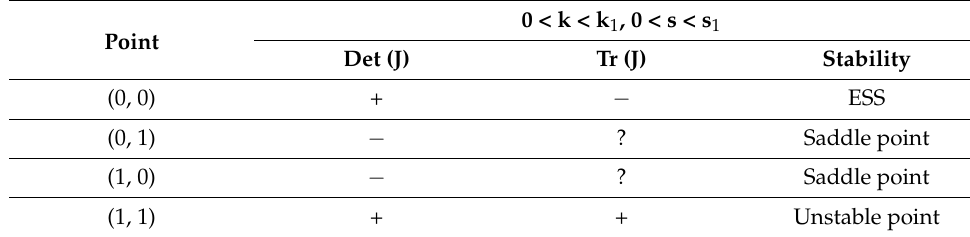
Table 15. Stability analysis of the points in case (1).